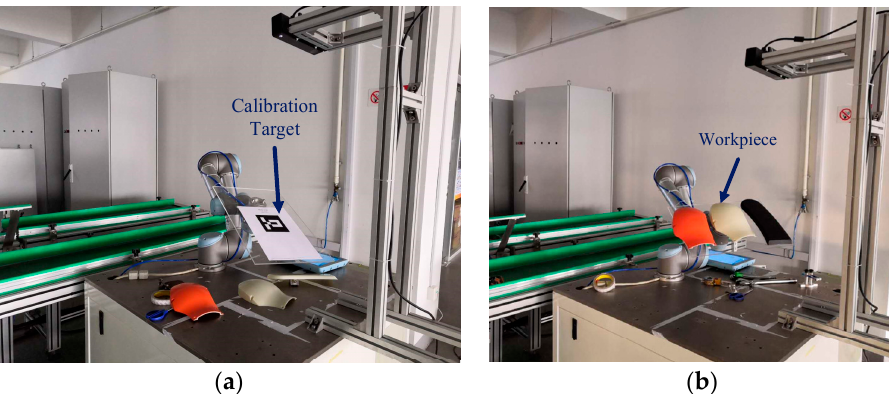
Figure 6. Hand-eye calibration and pose estimation experiment platform. ( a ) The camera is mounted